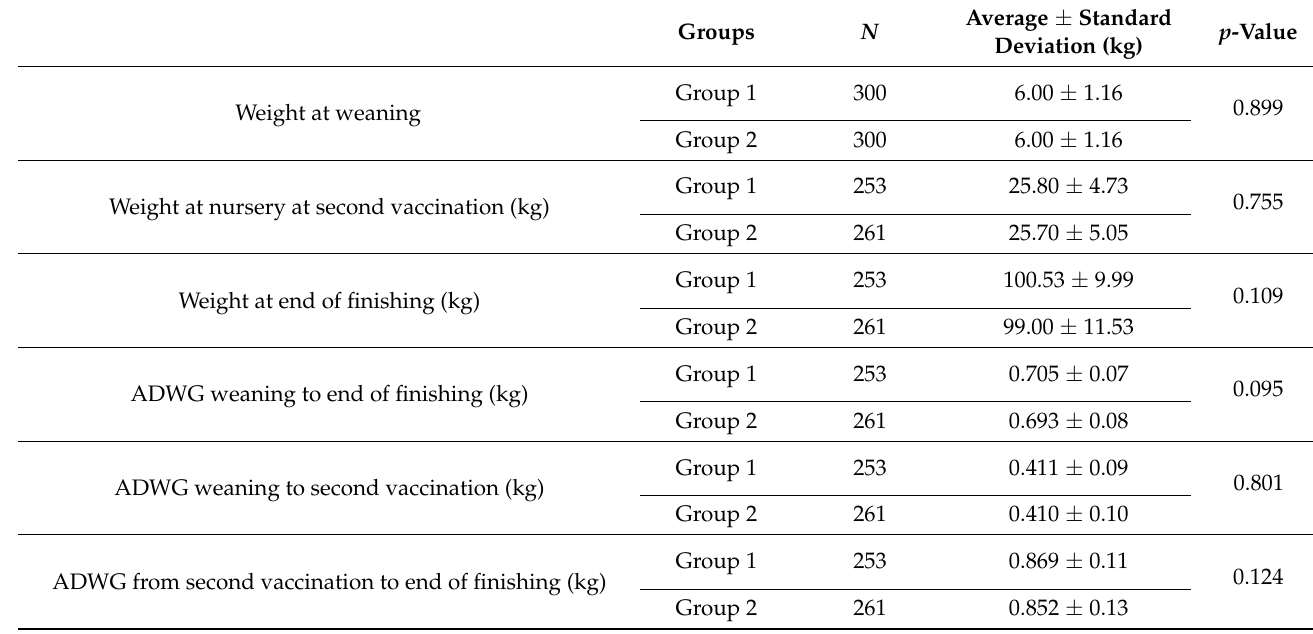
Table 1. Number of animals at the different weighing’s.